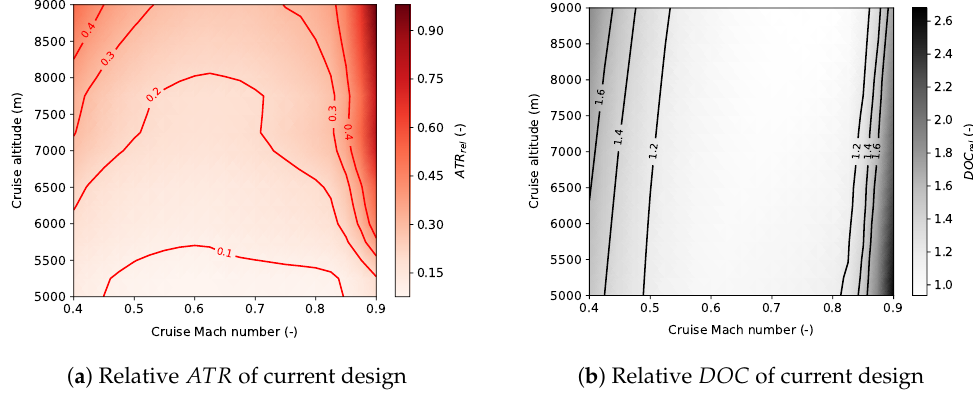
Figure 10. Variation of ATR and DOC relative to the A330-200 operating at Mach 0.82 and 11,250